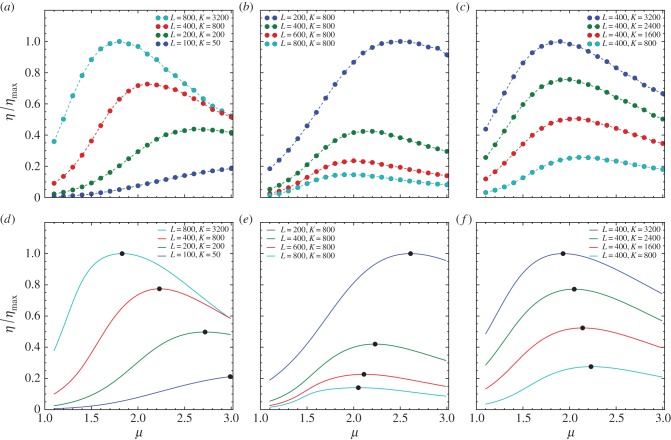
Panels (a–c) show the rescaled search efficiency η/ηmax versus the power-law exponent μ for different values of the landscape size L and the number of targets K from numerical simulation with the intensity of stochastic returning β = 0 and the termination condition Θn = δ(n − 20 000). The results are averaged over 100 realizations. The curves in panel (a) from bottom to top correspond to (L, K) = (100, 50), (200, 200), (400, 800), (800, 3200) such that the mean free path λ = 100 remains constant. The curves in panel (b) from top to bottom correspond to L = 200, 400, 600, 800 with K = 800 kept constant. The curves in panel (c) from top to bottom correspond to K = 800, 1600, 2400, 3200 with L = 400 kept constant. Panels (d–f) show η/ηmax evaluated by the mean-field solution, corresponding to the results from numerical simulation in panels (a–c), respectively. The black dots indicate the peak of the curves.